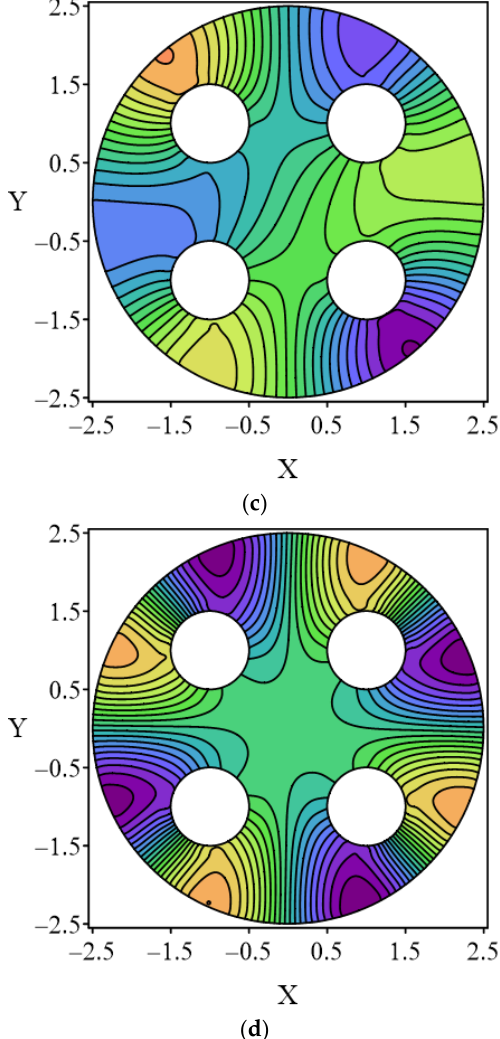
Figure 14. The first four eigenmodes for multi-connected domain waveguide (TE wave): ( a ) k 1 = 1.1741, ( b ) k 2 = 1.2202, ( c ) k 3 = 1.4969, and ( d ) k 4 = 1.9457.